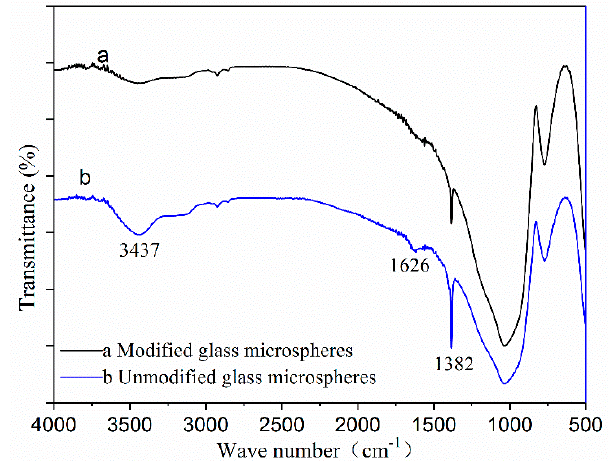
Figure 6. FTIR spectroscopy of before and after surface modification of glass microspheres.